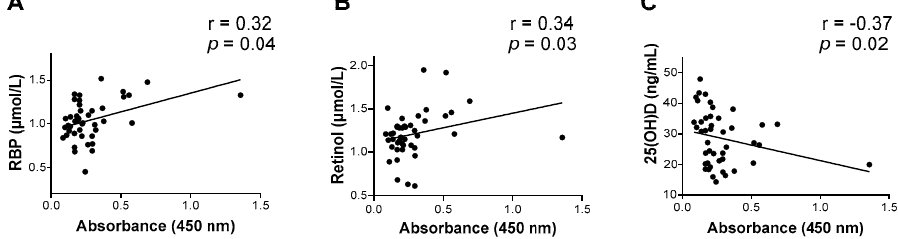
Figure 5. RBP and retinol, but not 25(OH)D, correlate with influenza virus B-specific binding antibodies in pediatric human sera. ( A ) RBP, ( B ) retinol, and ( C ) 25(OH)D are each plotted as a function of baseline scores for influenza virus B-specific binding antibodies. Each symbol represents a different participant. A simple linear regression line is plotted. Spearman correlation test results are shown.